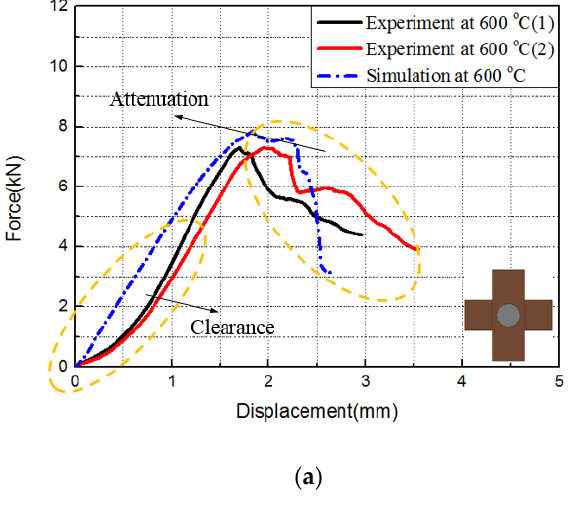
Figure 14. Force–displacement curves of hexagonal bolt joints at ( a ) 600 °C and ( b ) 800 °C .